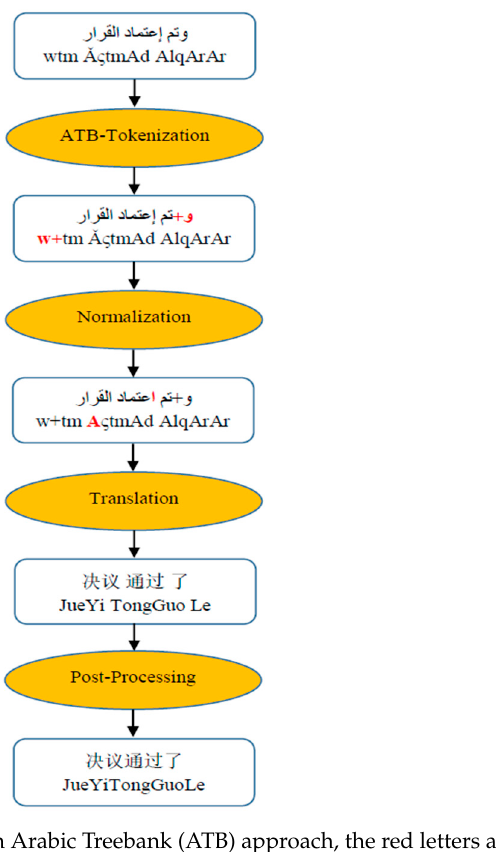
Figure 3. Step-wise result of the Penn Arabic Treebank (ATB) approach, the red letters are normalized and tokenized by the approach, Chinese pinyin is presented to ease readability.